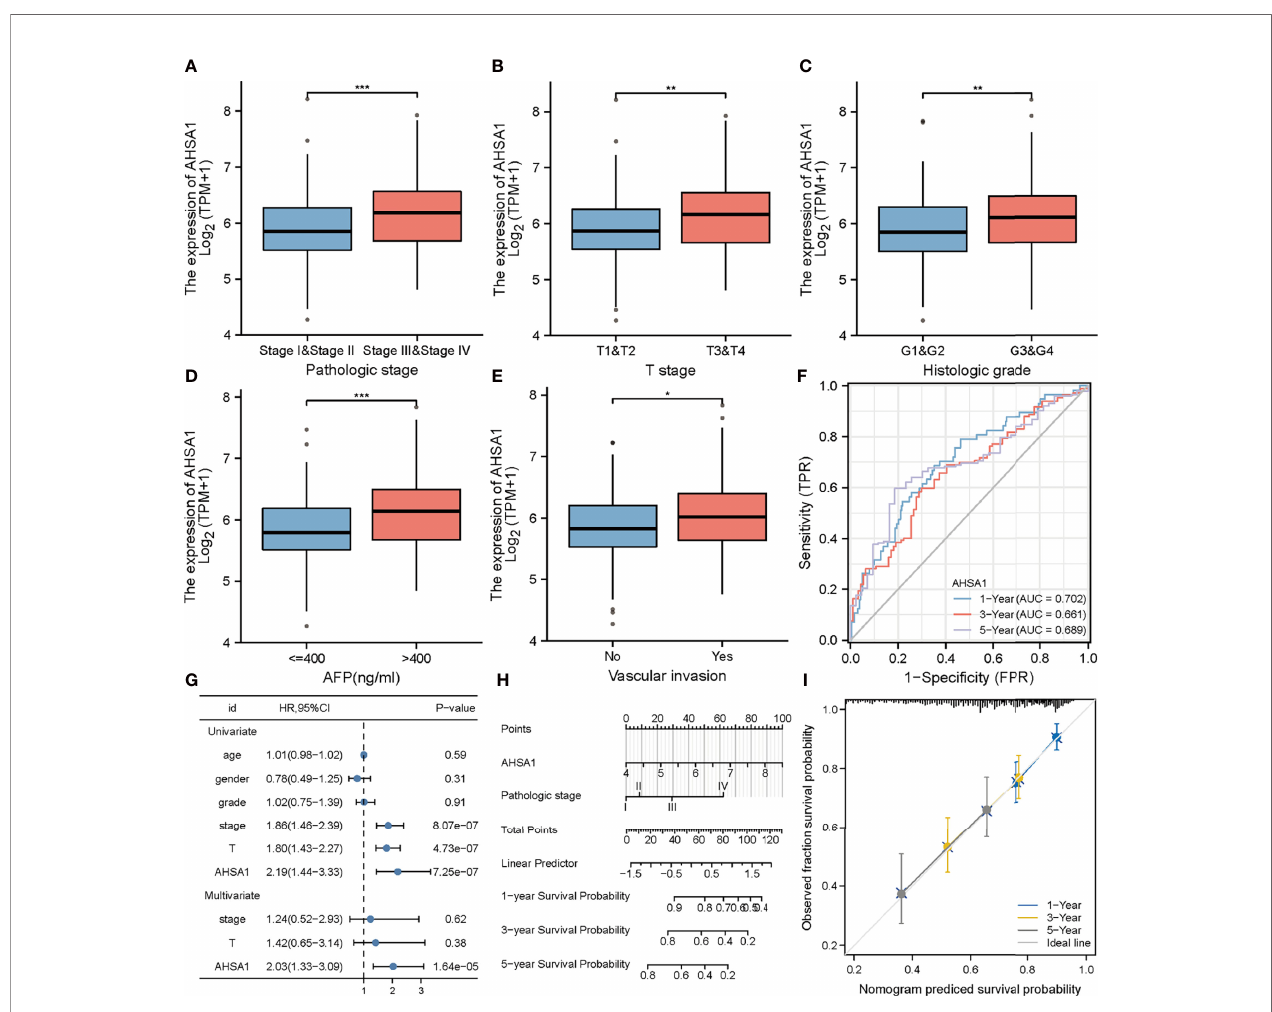
FIGURE 6 | Clinical correlation analysis of AHSA1 in hepatocellular carcinoma. Variation analysis of AHSA1 expression in different pathological stages (A) , T stage (B) , Histologic grade (C) , alpha-fetoprotein (AFP) (D) , Vascular invasion (E) . (F) Prognostic signi fi cance of AHSA1 in hepatocellular carcinoma was analyzed by COX analysis. (G) Prognostic signi fi cance of AHSA1 in hepatocellular carcinoma was analyzed by univariate and multivariate COX. (H) Nomogram based on AHSA1 expression and pathological staging. (I) Correction analysis diagram of the nomogram. *p<0.05, **p<0.01,